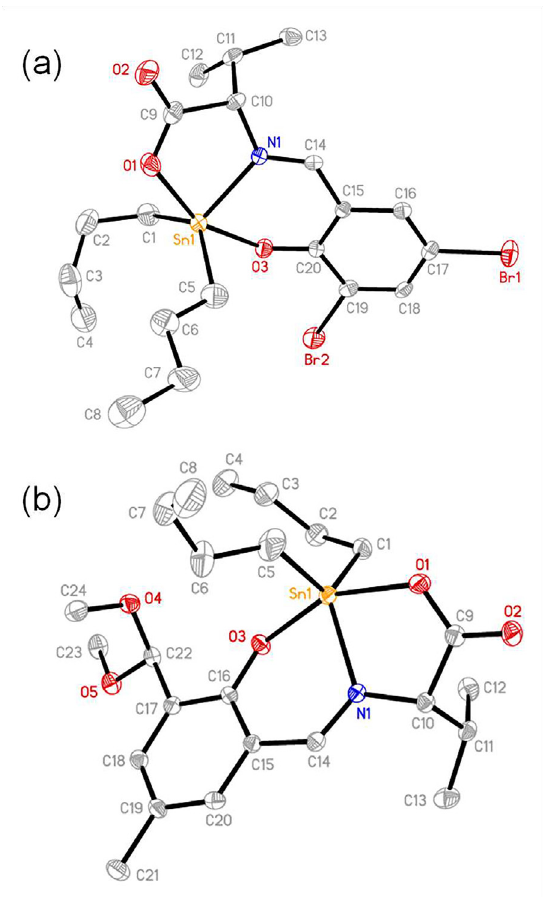
Figure 3: The molecular structures of 4 (a) and 5 (b). Ellipsoids are drawn at the 30% probability level. Hydrogen atoms are omitted for clarity.